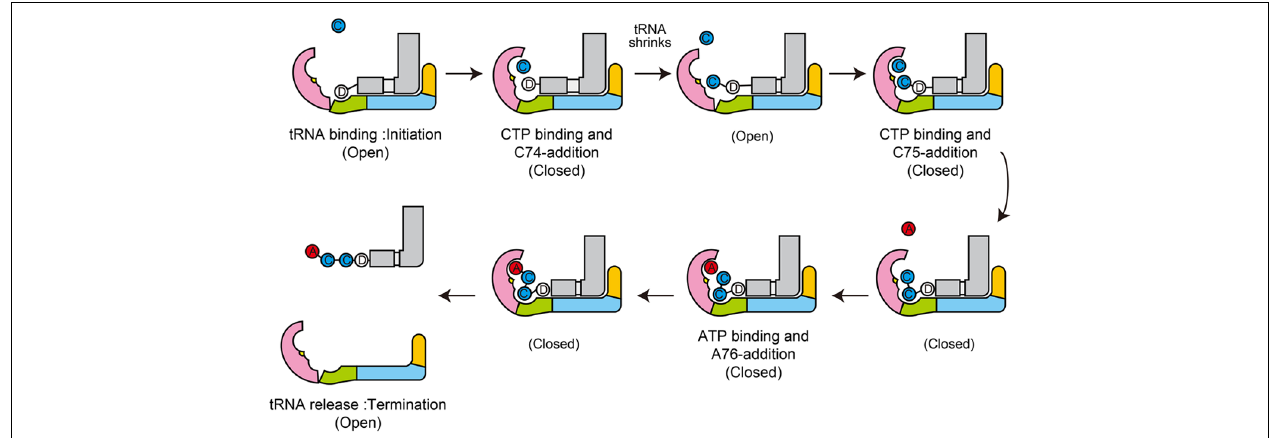
FIGURE 4 | Mechanism of CCA-addition by class-I CCA-adding enzymes. Schematic representation of the CCA-adding reaction by class-I CCA-adding enzymes.The N-terminal, central, C-terminal, and tail domains are colored magenta, green, cyan, and orange, respectively. tRNAs are colored gray. Catalytic sites are colored yellow in the N-terminal